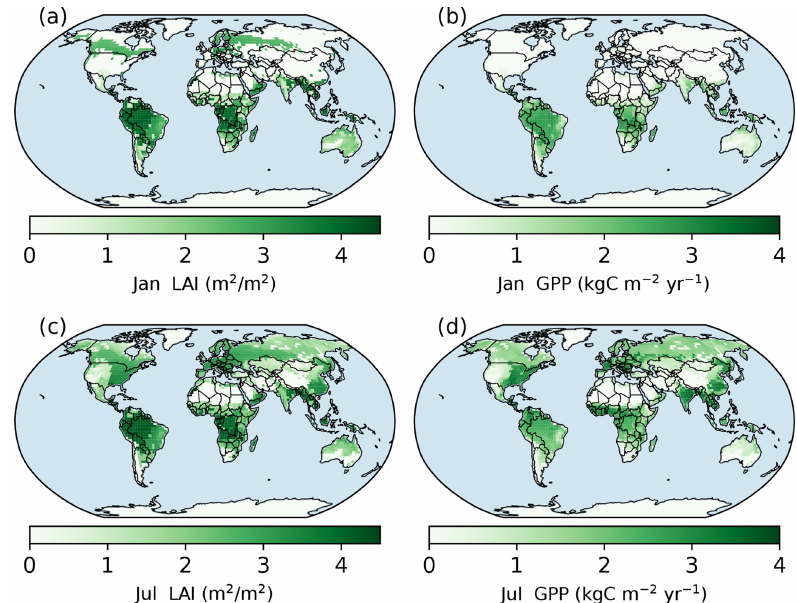
Figure 6. Spatial patterns of LAI and gross primary production (GPP) in January and July simulated with the full demography model setting. Panels (a) and (b) are the LAI and GPP of January in the year of 600 (the last year of model run). Panels (c) and (d) are the LAI and GPP of July in the same